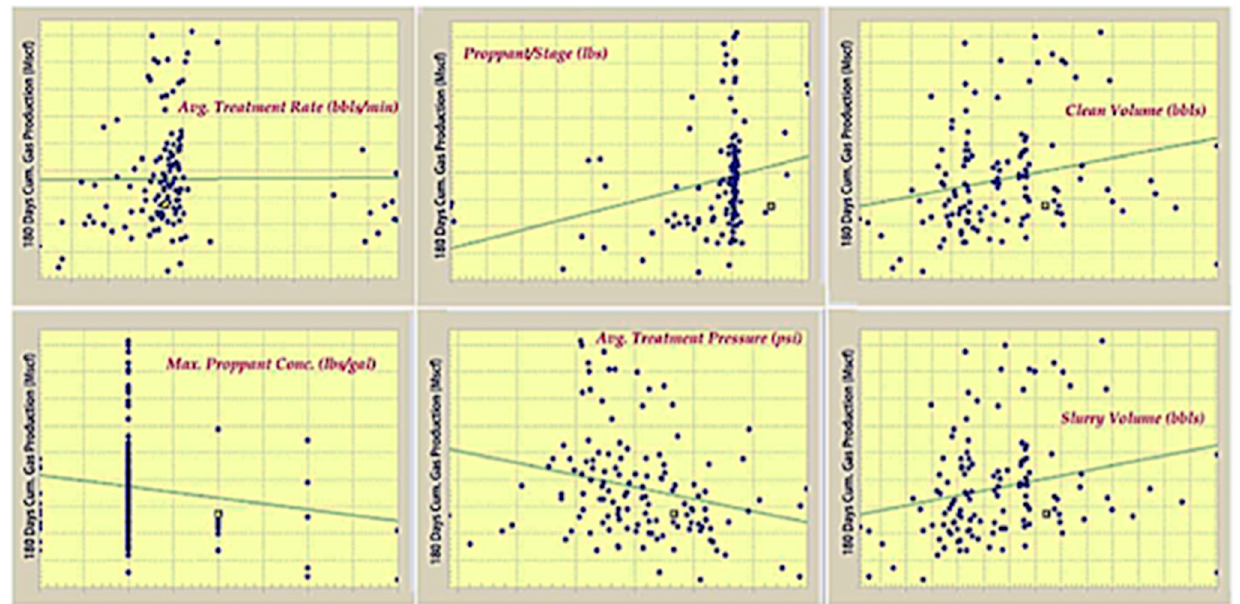
Figure 1. Correlations between well productivity and field treatment data from Mohaghegh (2019).